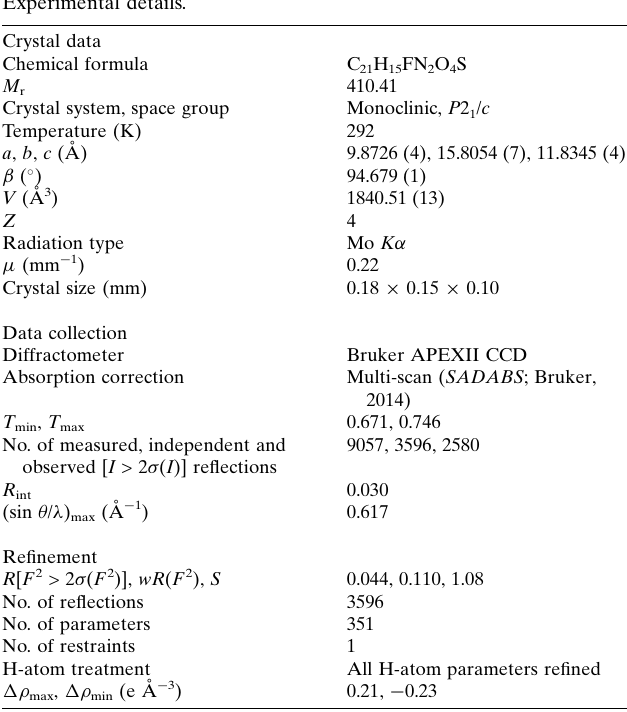
Table 2 Experimental details.